Question: Give a one-sentence summary of this figure.
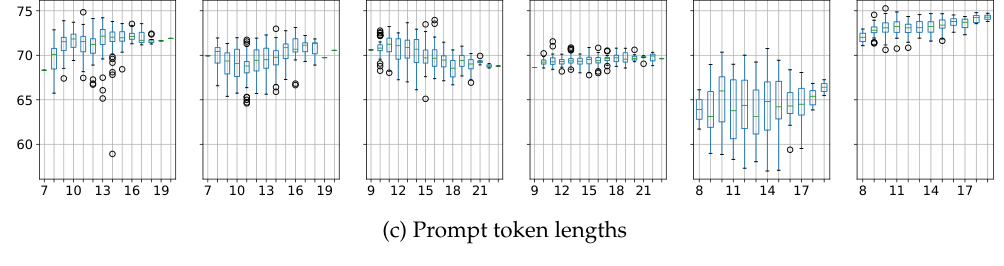
Answer: M-MEM scores grouped by different prompt properties on the dev set.